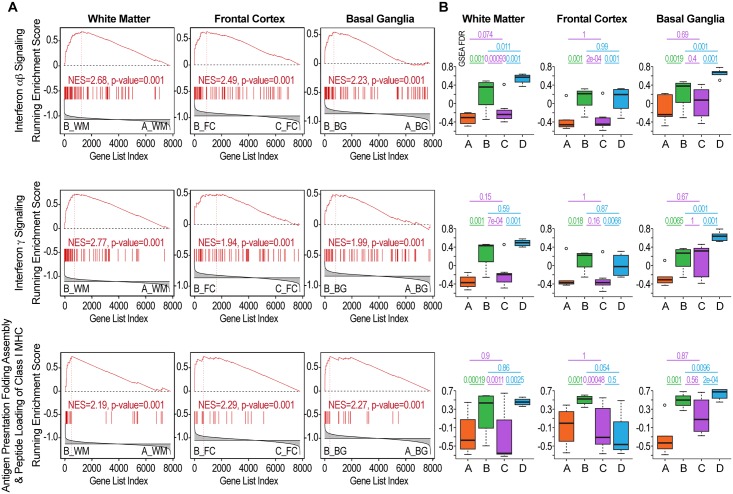
Differential regulation of IFN-related pathways in the groups of the NNTC gene expression dataset.A) Gene expression evidence of interferon (IFN) activation in HIV-infected patients without NCI. The diagrams show GSEA plots for 3 pathways representative of IFN activation in HIV-infected patients without NCI (group B, left-hand side in the GSEA plot) as compared to uninfected controls (group A, right-hand side). Each pathway was tested in each region independently. WM = White Matter; FC = Frontal Cortex; BG = Basal Ganglia. These pathways are indicative of type I IFN activation and include IFN-related genes in Top) INTERFERON ALPHA BETA SIGNALING, Middle) type II IFN activation (INTERFERON GAMMA SIGNALING), and Bottom) ANTIGEN PRESENTATION FOLDING ASSEMBLY AND PEPTIDE LOADING OF MHC CLASS I, a pathway involving several IFN-regulated MHC class I genes. Significant changes in the expression of the pathways is indicated by the asymmetric distribution of the genes in the geneset (vertical bars) and of the running enrichment score plot (ES) (19). Genes participating in the enrichment (on the left of the leading edge corresponding to the peak of the running enrichment in GSEA) are shown in Fig 3. B) Differential regulation of IFN-related pathways in the 4 groups of the NNTC gene expression dataset. Significant activation of pathways related to both type I and type II IFN was seen in a brain region-specific pattern in HIV-infected patients without NCI (group B) and in patients with HIVE (group D). Top) INTERFERON ALPHA BETA SIGNALING in the white matter, frontal cortex and basal ganglia; Middle) INTERFERON GAMMA SIGNALING; and Bottom) ANTIGEN PRESENTATION FOLDING ASSEMBLY AND PEPTIDE LOADING OF MHC CLASS I, in the same three regions. Each plot represents the pathway activity (computed as an enrichment score) in the 4 different phenotypes and is annotated with the FDR values of respective GSEA comparisons.